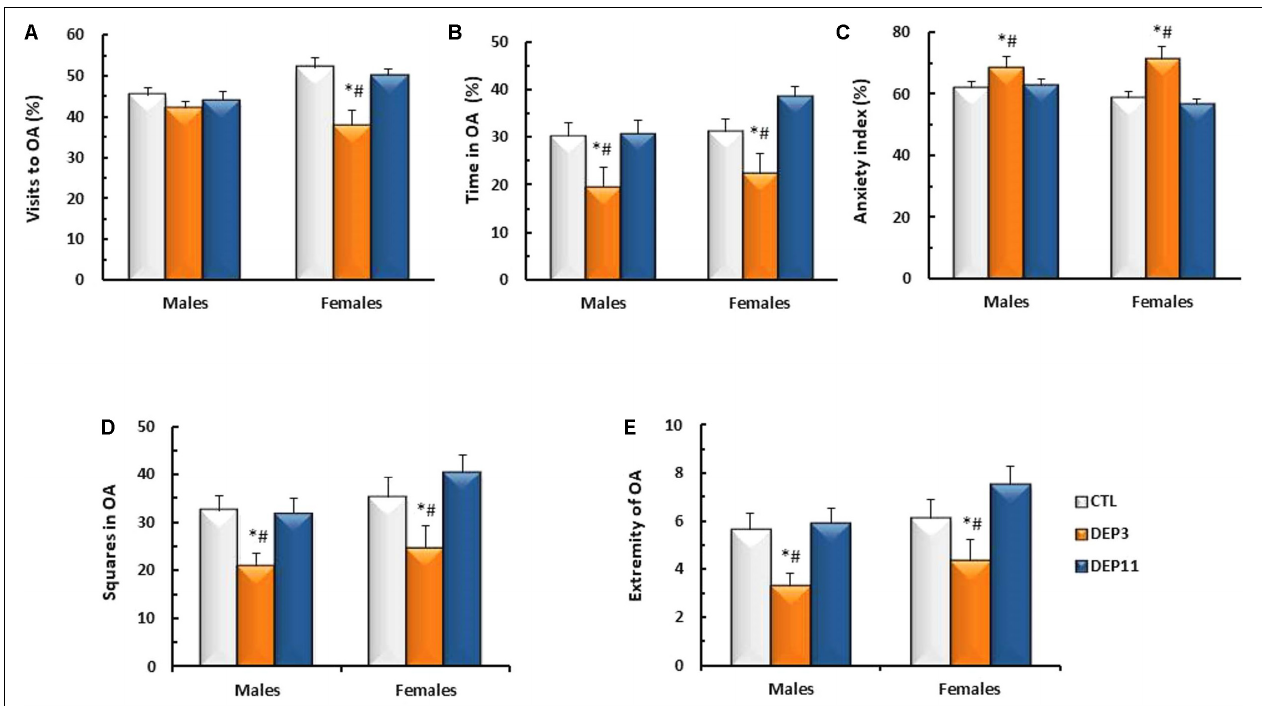
FIGURE 4 | Percentage of visits (A) and time spent (B) in the open arms (OA); anxiety index (C) ; number of squares crossed in the OA (D) and number of times that the animals reached the far end of the OA (E) during a 5 min session in the elevated plus maze. Animals were maintained with their mothers (CTL), deprived on postnatal day (PND) 3 (DEP3) or on PND 11 (DEP11) and tested between PNDs 52 and 60. Data are presented as mean ± SEM of 9–12 animals/group/sex. ∗ – Different from CTL group; # – different from